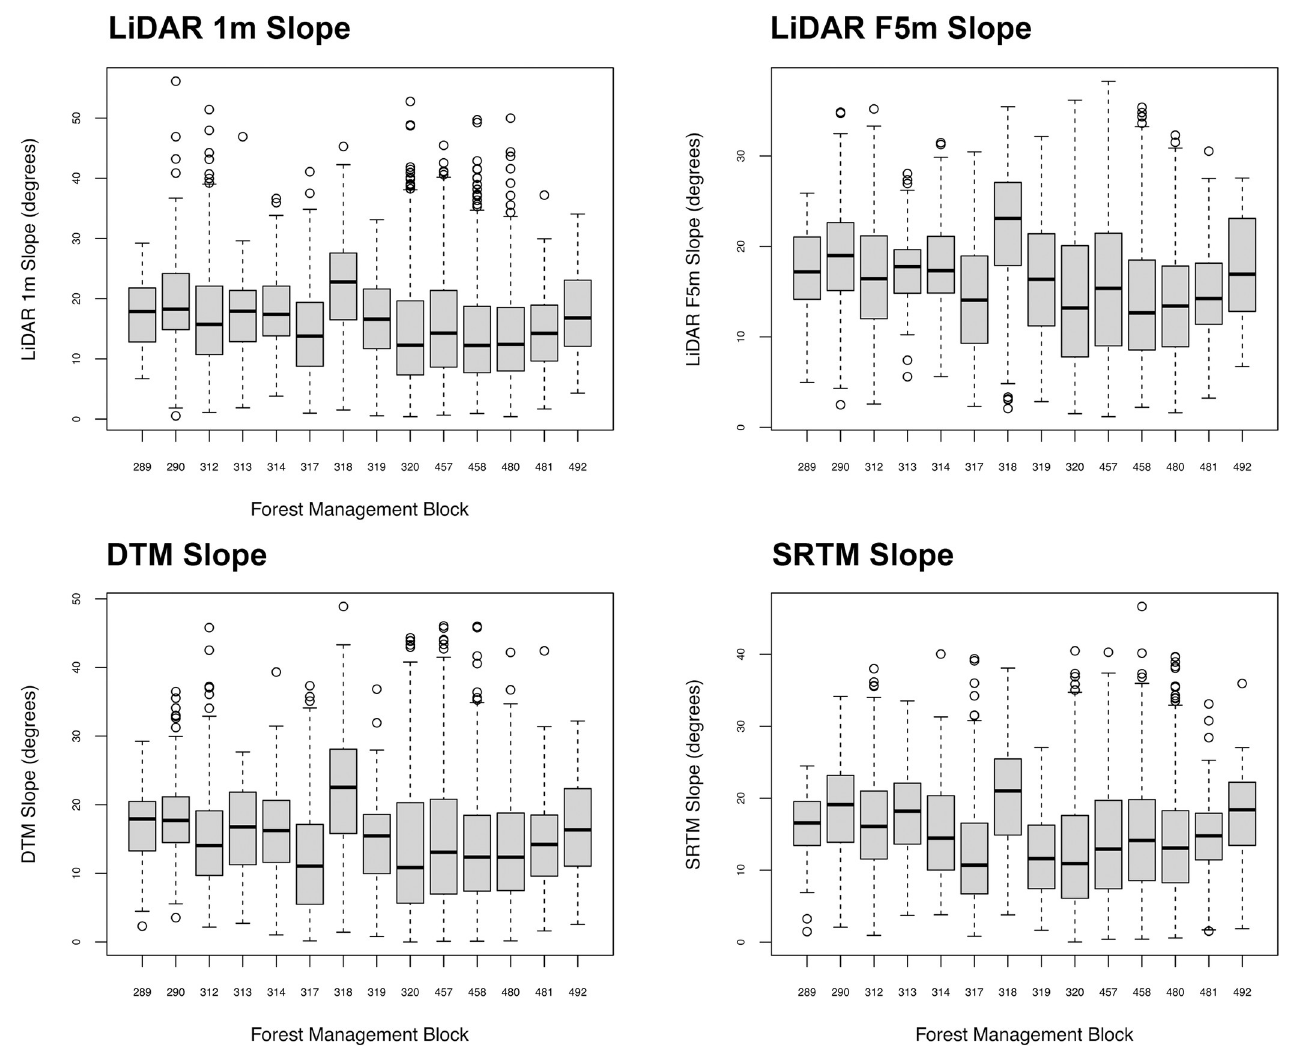
Fig 5. Comparison of slopes logged across forest management blocks across the Upper Goulburn and Thomson water supply protection areas.